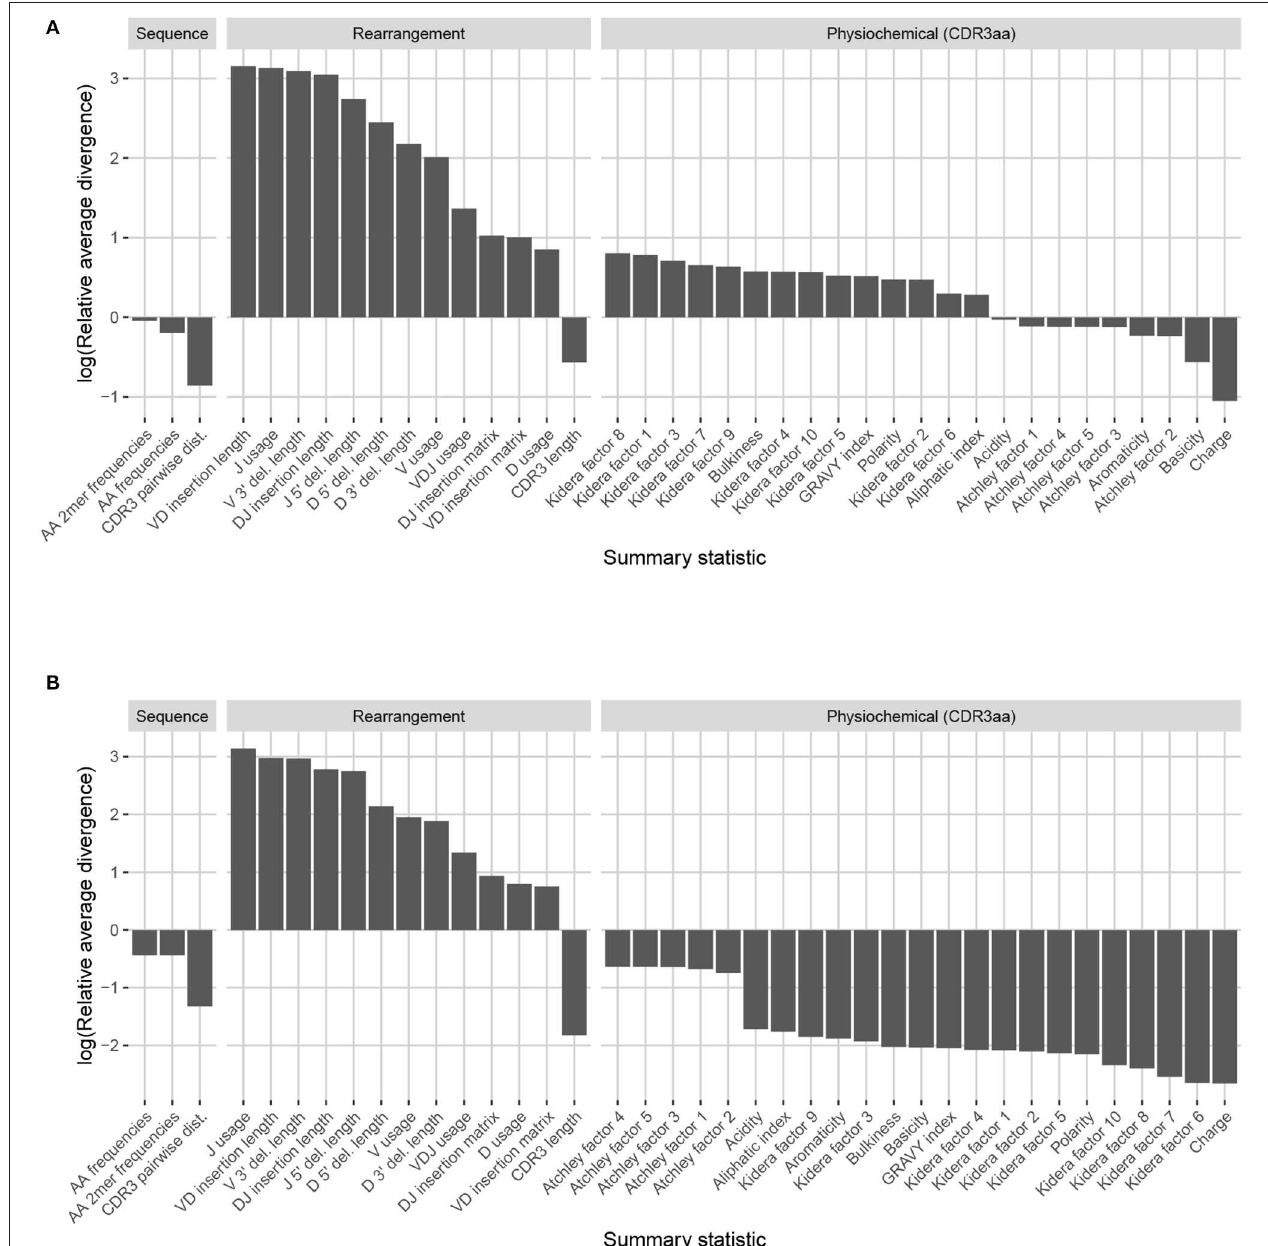
FIGURE 7 | Summary scores, denoted as “log(Relative average divergence)” or “LRAD,” for each statistic in the IGoR model validation experiment. For both cases, a high score indicates a well-replicated statistic by the simulations with respect to their corresponding experimental repertoires of functional TRB sequences. (A) LRAD-data values for each relevant TRB statistic available from IGoR or IgBLAST as determined by Equation (8). (B) LRAD-sim values for each relevant TRB statistic available from IGoR or IgBLAST as determined by Equation